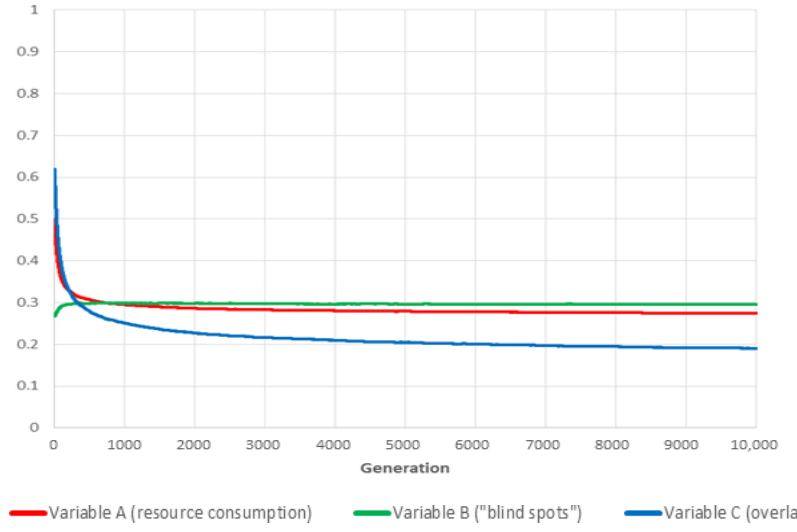
Figure 7. The curves show the evolution over time of the three global variables (for the values α = γ = 1 , γ = 2 ) for the fittest individual of each generation (the shown results are averaged over 4 4 180 independent realisations).